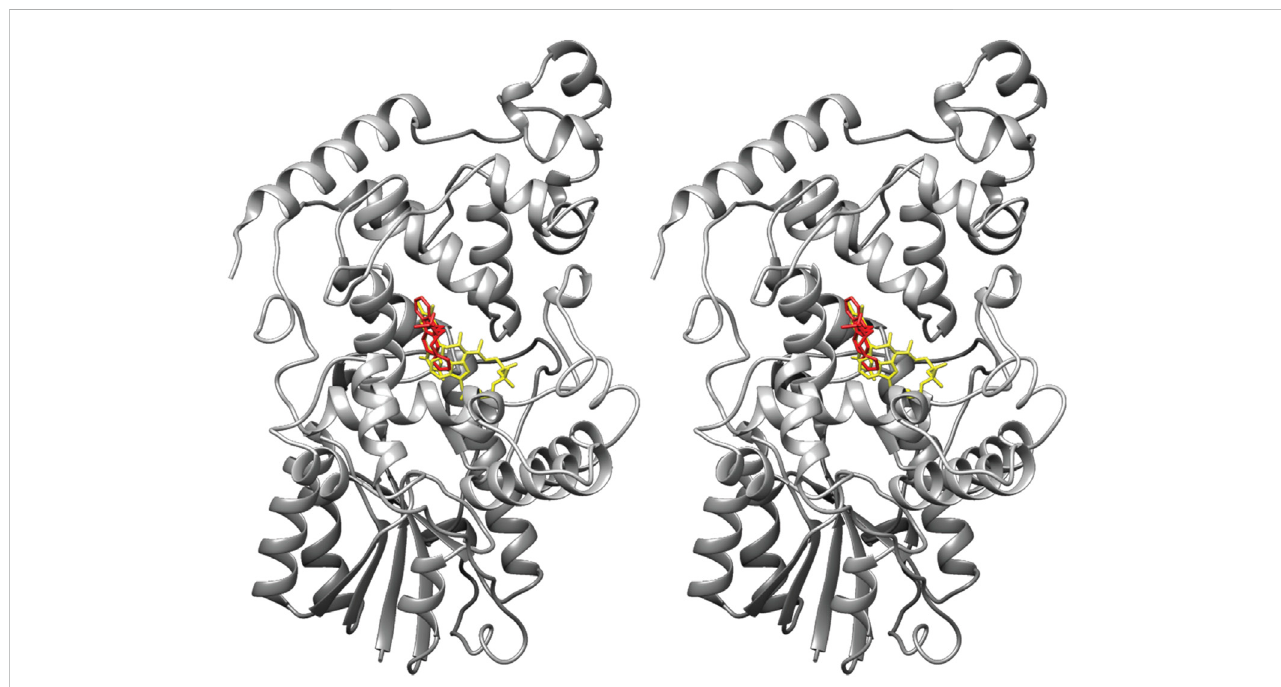
FIGURE 2 A stereoview of murine cryptochrome 2 with bound KL001 (red) (PDB ID code 4MLP). The position of FAD (yellow) in the FAD-binding pocket was superimposed from the Cry2-FAD structure (PDB ID code